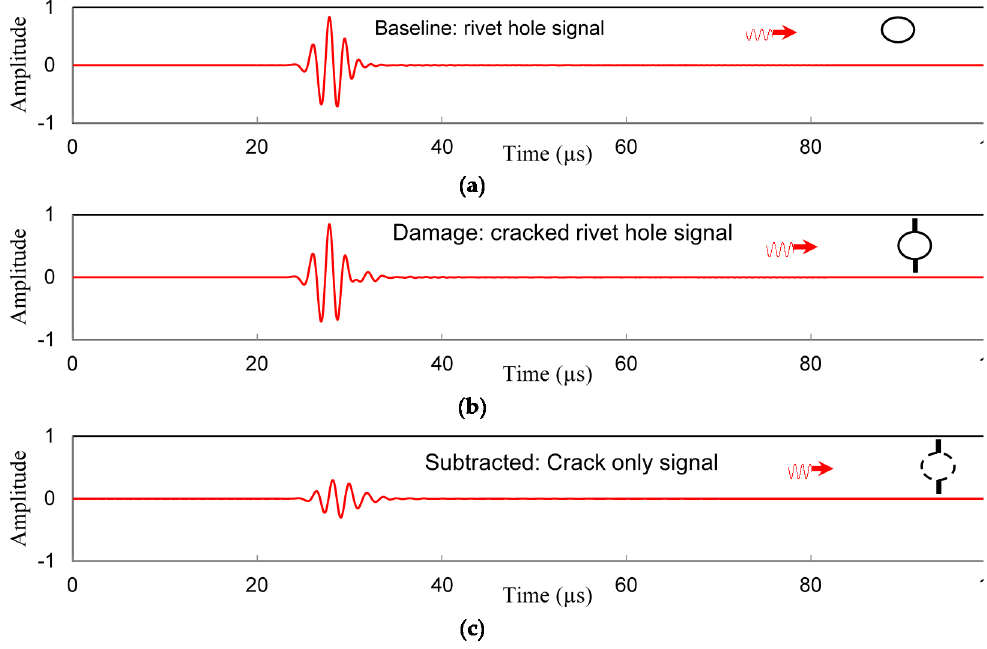
Figure 10. The wave fields for ( a ) Hole; ( b ) Hole + Crack ( c ) Crack only ( f “ 538 kHz, θ “ 0 ˝